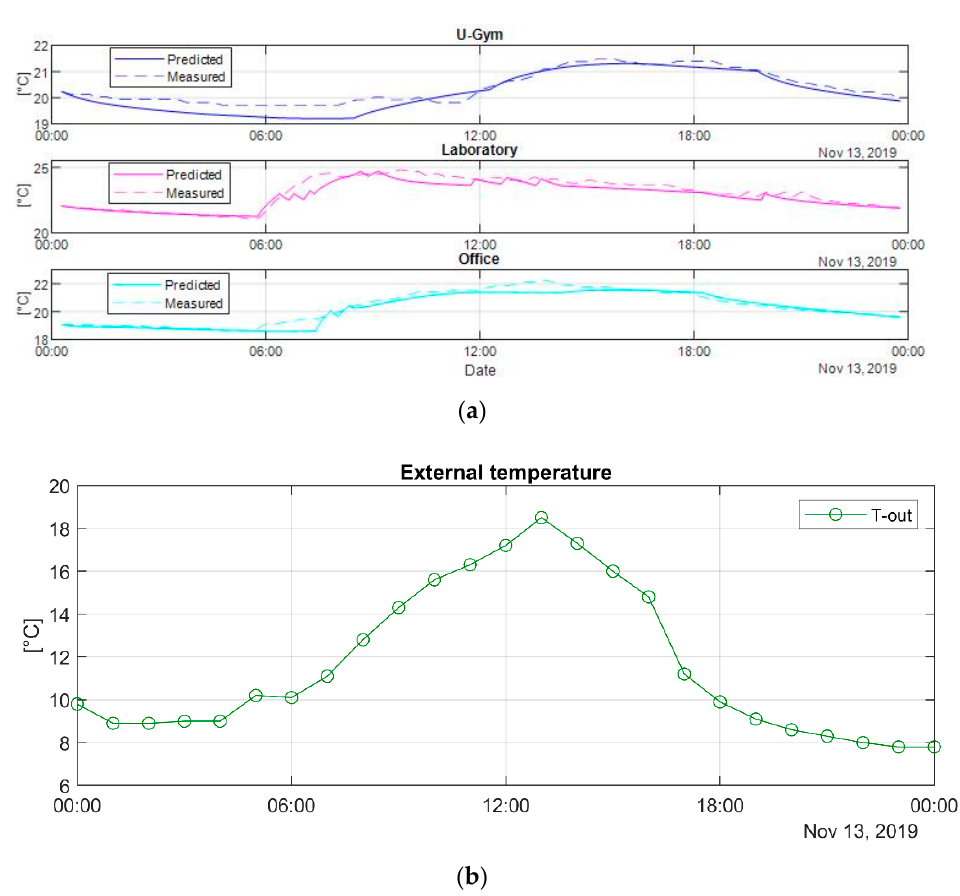
Figure 11. ( a ) Daytime room temperatures. ( b ) Daytime external temperatures. Energies 2019 , 12 , x FOR PEER REVIEW